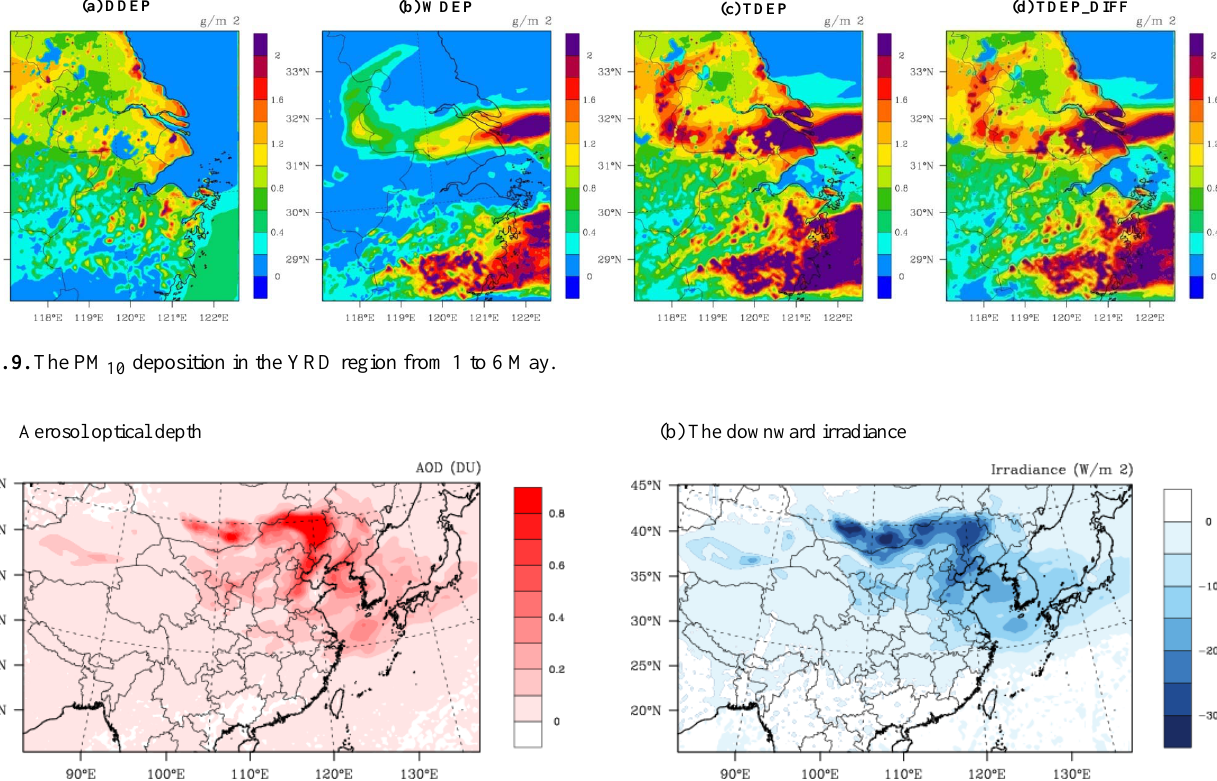
Fig. 10. The average differences of the aerosol optical depth (AOD) at 550nm and downward irradiance simulated by DUST_REVISED and DUST_OFF, 28 April to 6